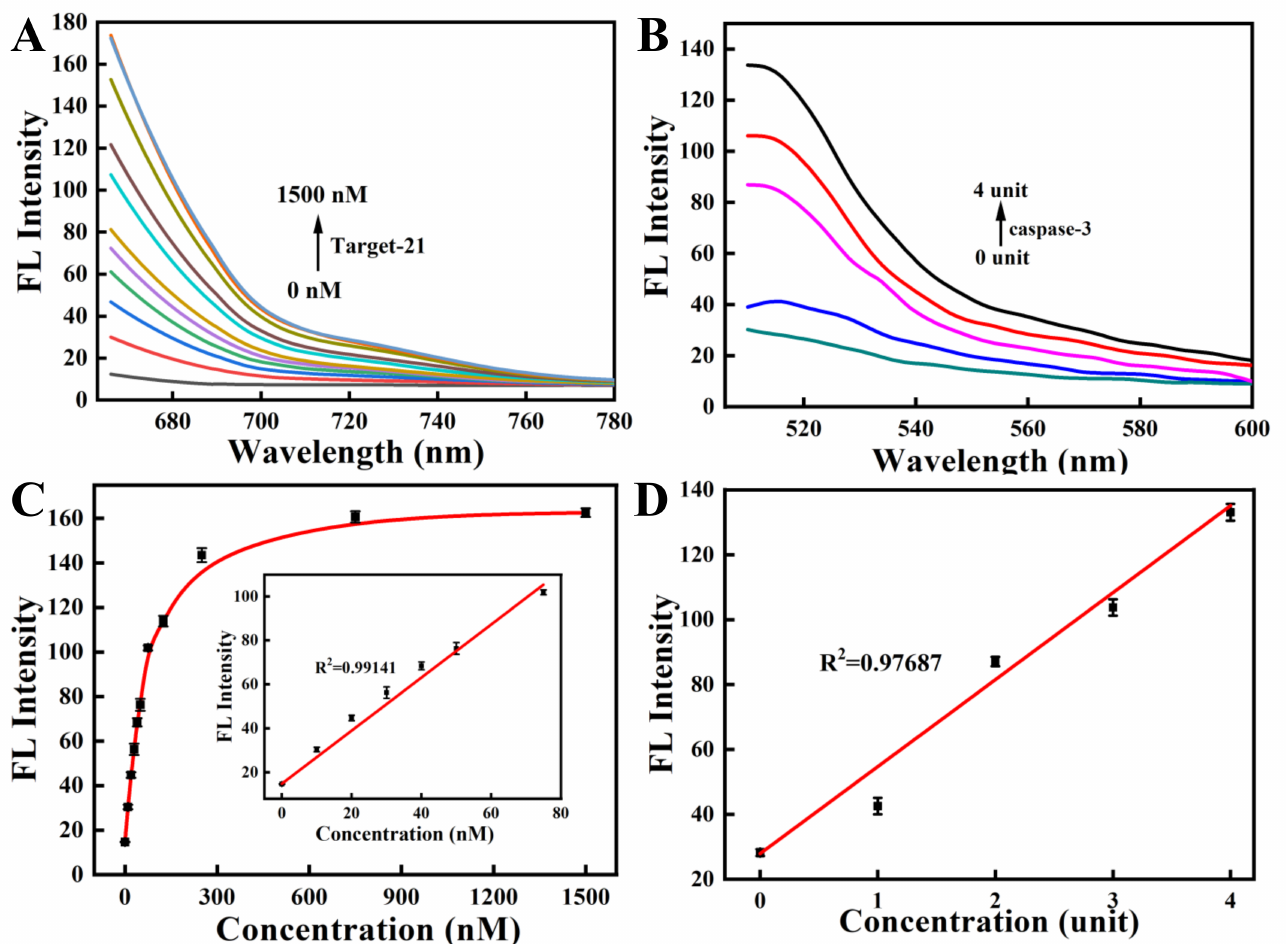
Figure 4. The fluorescence response spectra of the nanoprobe with various concentrations of miRNA-21 ( A ) and caspase-3 ( B ). The fluorescence recovery of the nanoprobe in the presence of miRNA-21 ( C ) and caspase-3 ( D ). (Inset: linear relationship for miRNA-21 concentrations ranging from 0 to 75 nM).